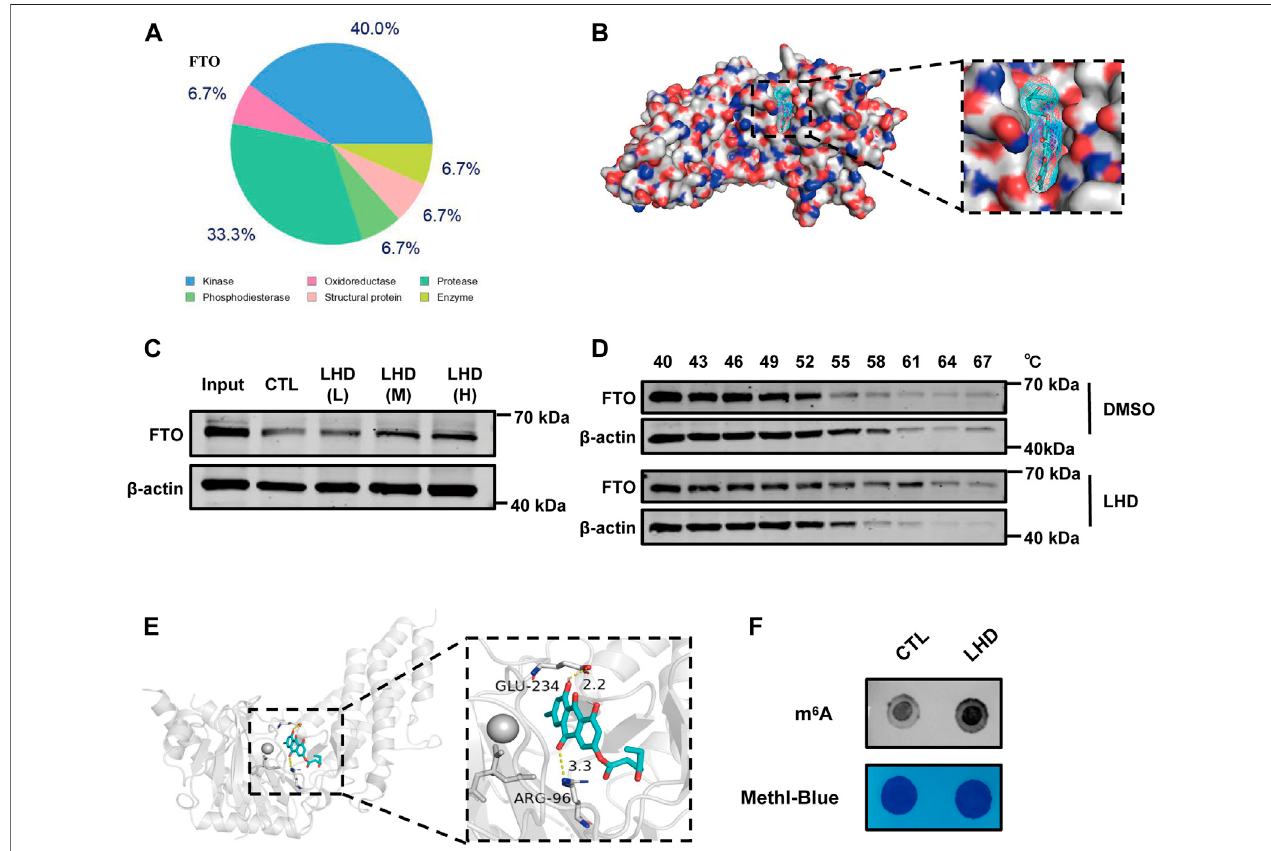
FIGURE 4 | LHD binds the FTO protein and regulates the level of m 6 A modi fi cations. (A) The top 15 compounds most likely to bind LHD. (B) Docking models simulatingLHDbindingintotheFTOcrystalstructure(PDBID:3LFM). (C) RepresentativewesternblottinganalysisofFTOfromtheDARTSassay.AC16cellslysateswith 83.4 (LHD L), 166.7 (LHD M), and 250.0 (LHD H) µM LHD were incubated for 1 h at room temperature before pronase digestion, n (cid:1) 3. (D) Western blotting analysis of the thermal stability ofFTO in LHD-treated cells, n (cid:1) 3. (E) Structure of the complex ofFTO bound with LHD; the yellow dotted lines indicate hydrogenbonding. (F) Determination of the abundance of the modi fi cation in 25 µM LHD-treated cells after 16 h, n (cid:1) 4.